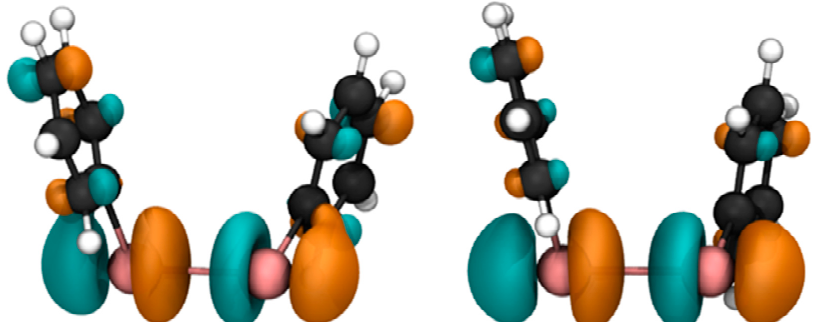
Figure 7. LUMO of Ph 2 Te 2 : relaxed geometry ( left ) and geometry with the maximum imposed Te–Te bond deformation ( right ). Isodensity 0.05 a.u. Level of theory: ZORA-OPBE/QZ4Pae//ZORA- OPBE/TZ2P.